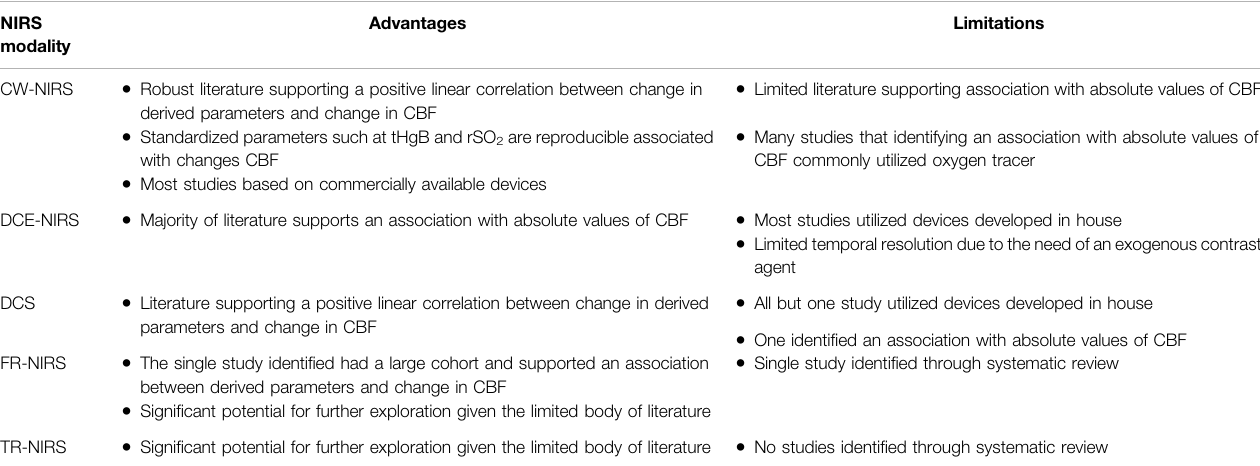
TABLE 4 | Summary of limitations and advantages of various NIRS modalities identi fi ed through this